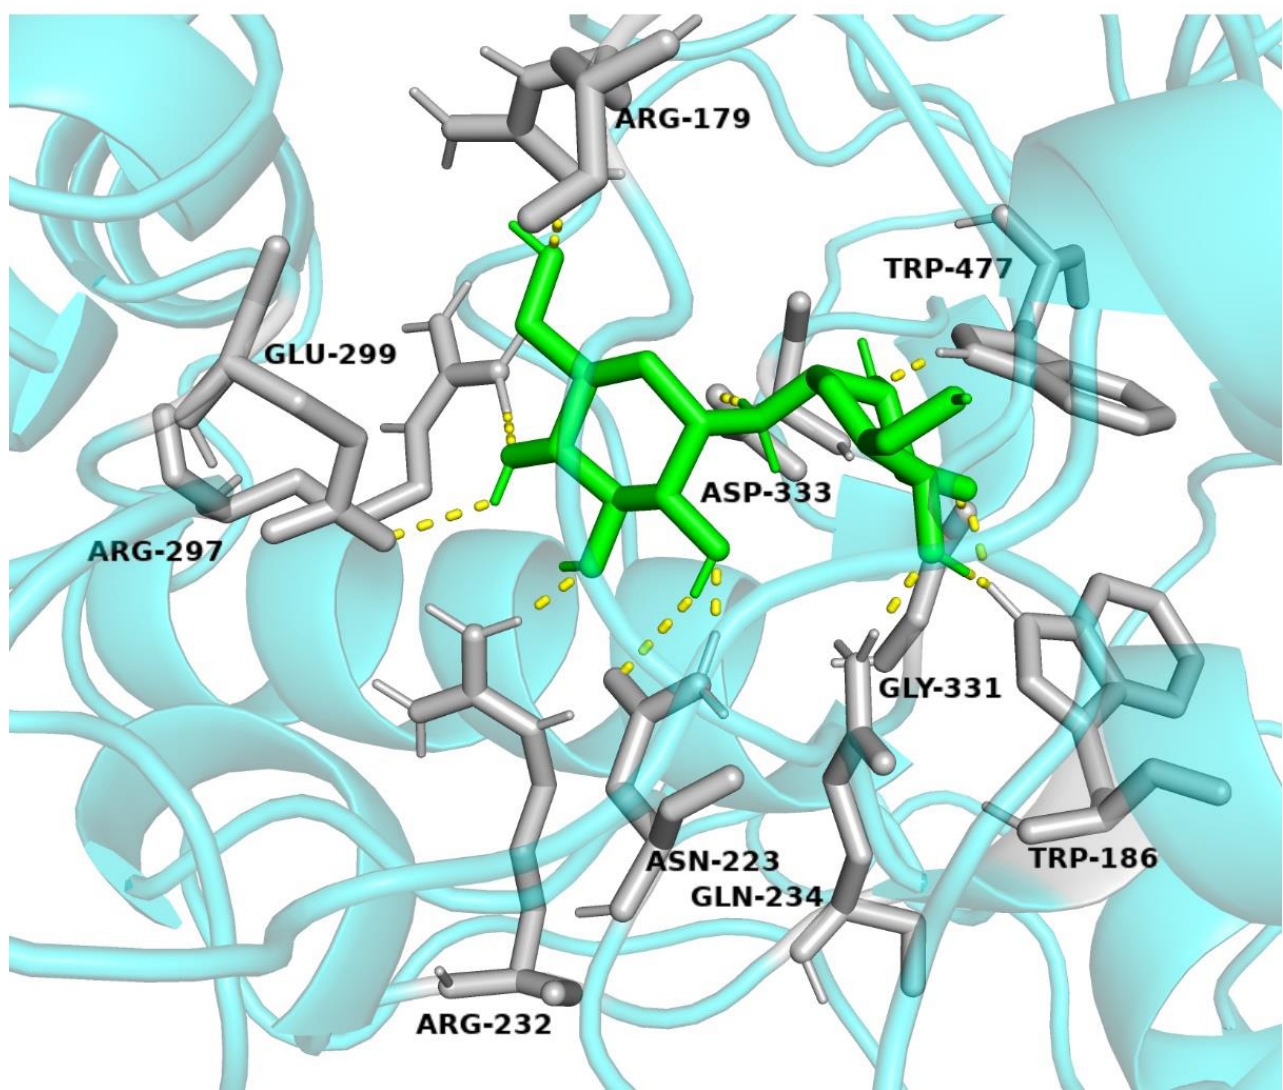
Figure 7. Molecular docking of LoTRE1 . The ligands and the key residues are shown as stick models. Hydrogen bonds are shown as yellow lines, ligands are shown in green, and key residues are shown in grey. The figure was drawn using PyMOL.